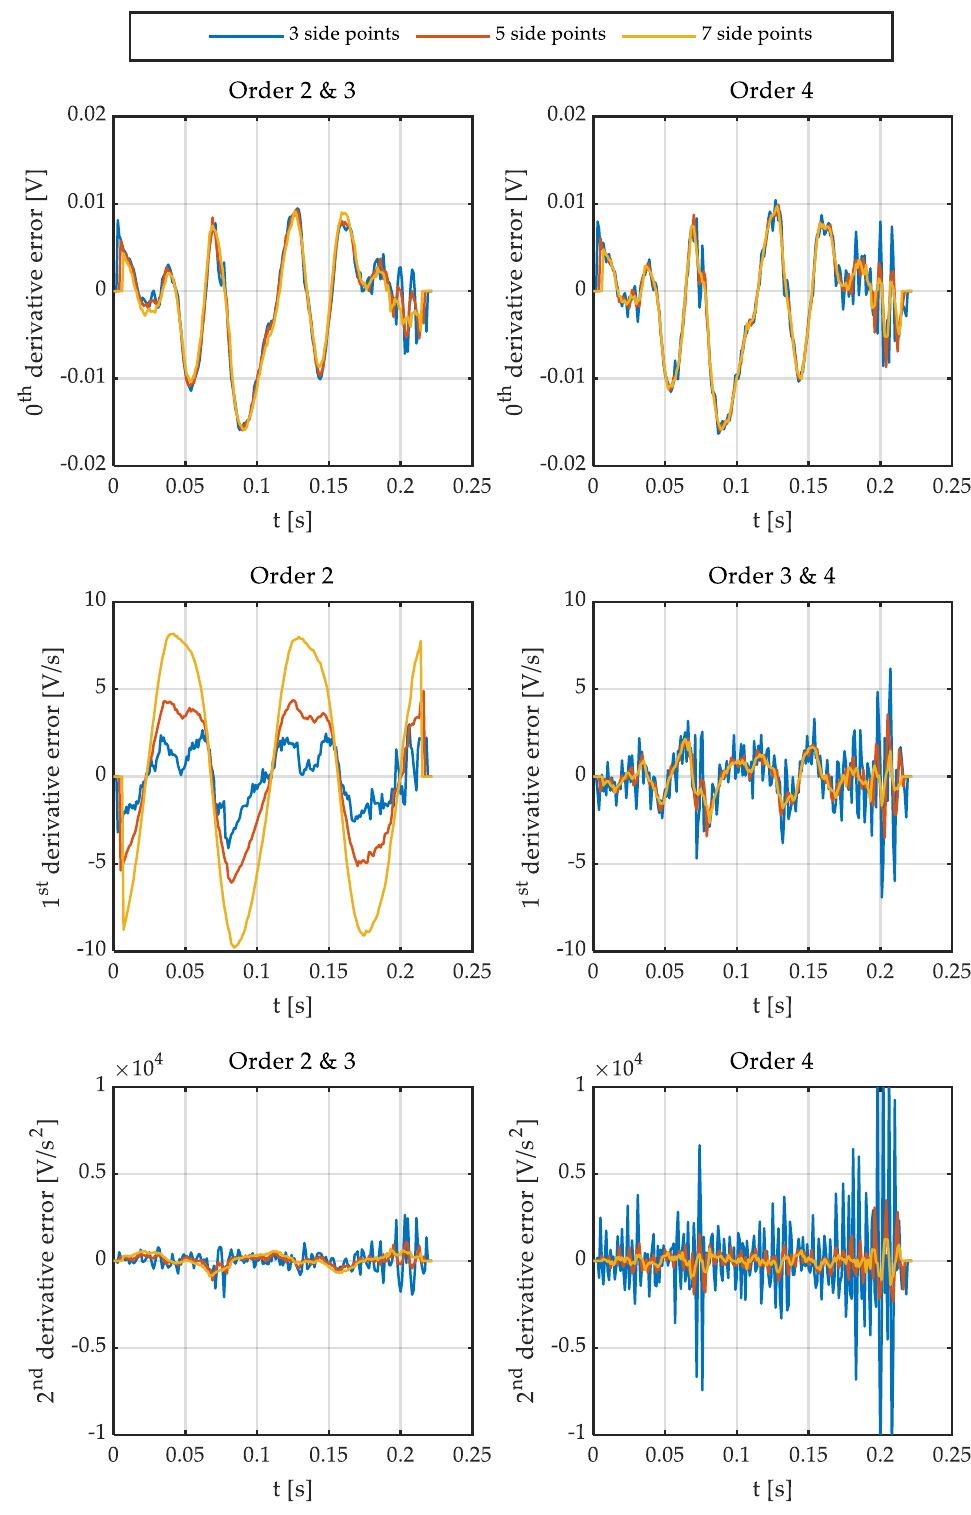
Figure 2. Errors of the signals fitted by polynomials using the Savitzky-Golay method. ( top ) zeroth derivative. ( center ) first derivative. ( bottom ) second derivative.